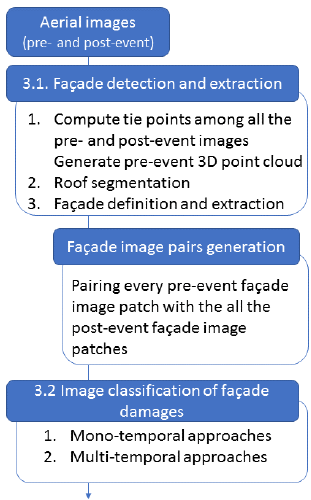
Figure 3. Overview of the steps of the facade damage detection using multi-temporal oblique